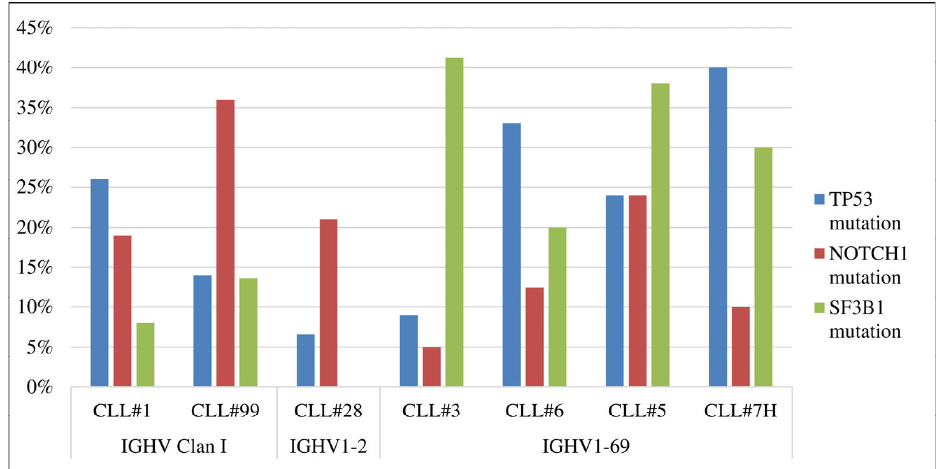
Figure 1. Genetic profile of the most common SAR subgroups in Russian CLL patients.